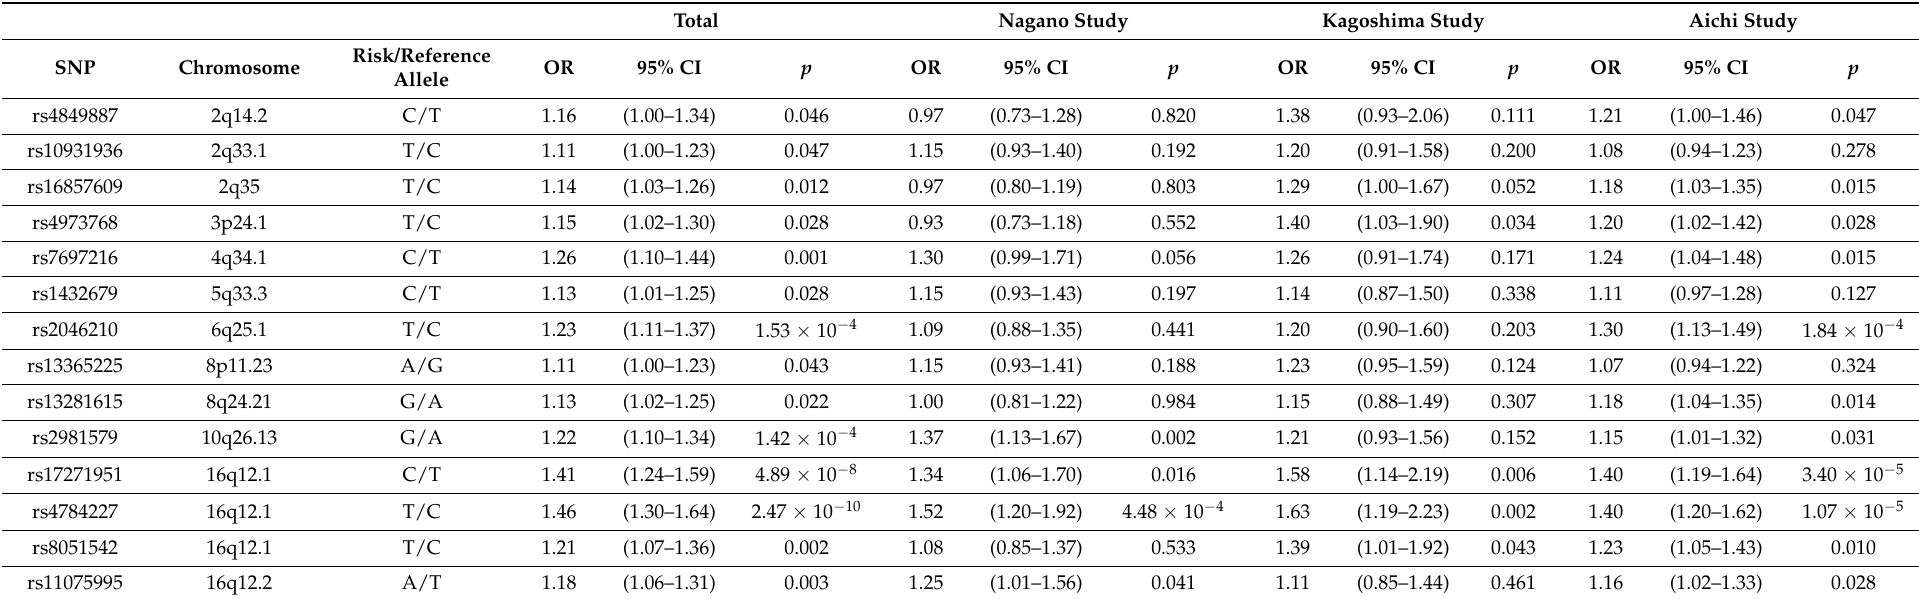
Table 2. SNPs with a significant association with breast